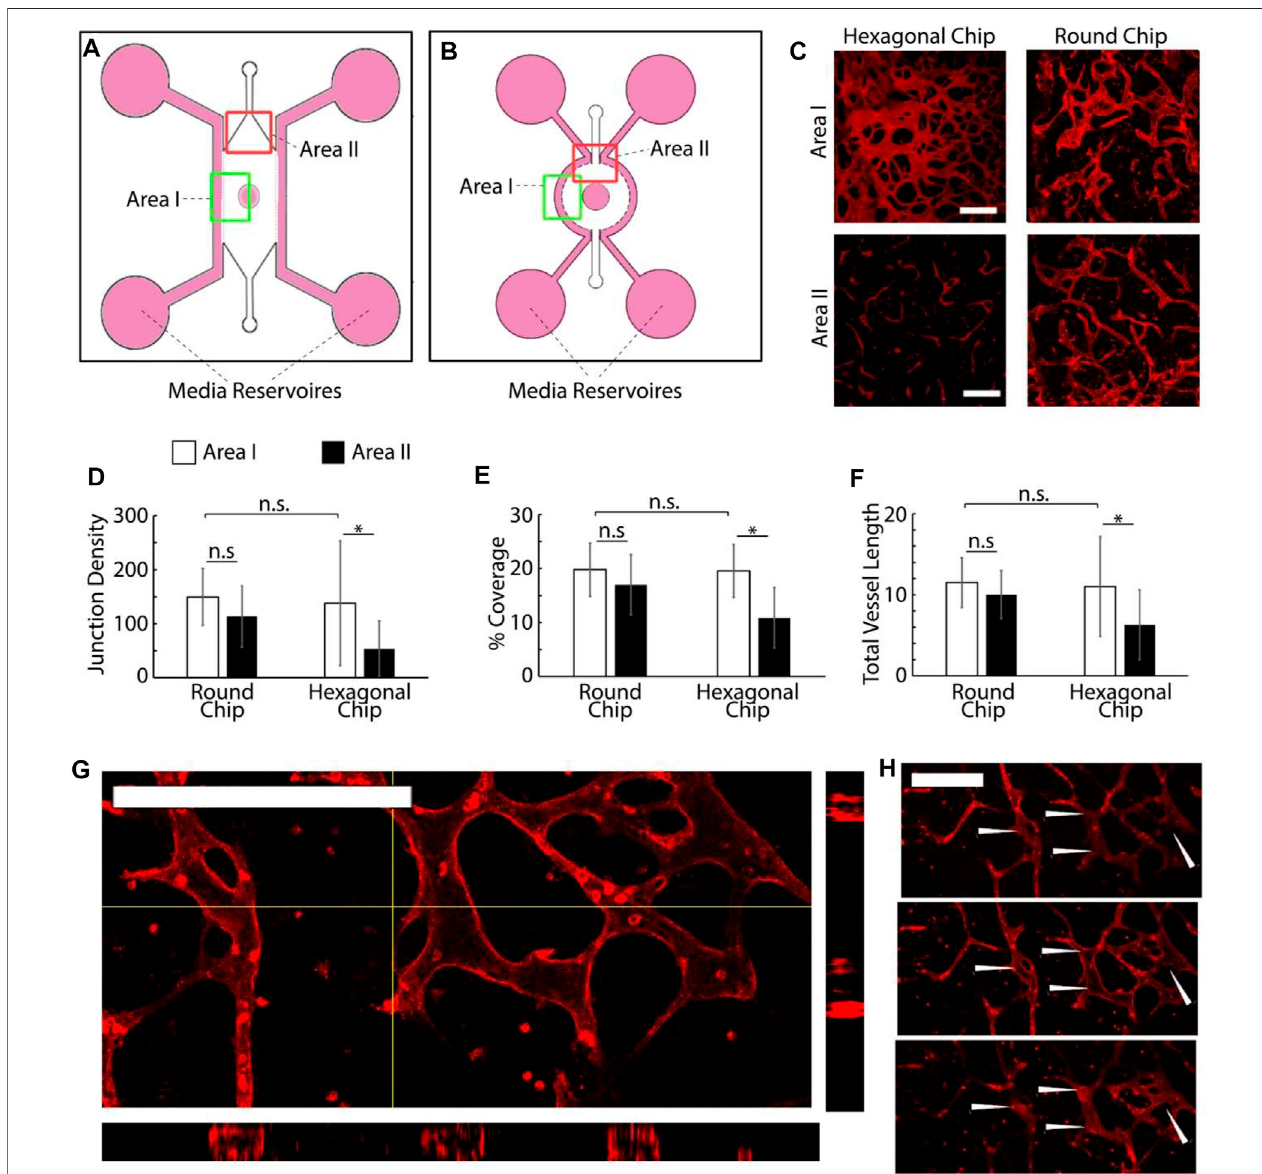
FIGURE 2 | (A,B) Schematic representation of the two chip designs investigated. (C) Examples of microvascular networks formed in different areas of the central compartment of hexagonal and round chips. Scale bars: 200 μ m. (D – F) (D − F) Quanti fi cation of the morphology of the corresponding networks. Junction density and total vessel length are expressed in arbitrary units normalised by the section area. (G – H) Confocal images of networks formed in round chips displaying luminated structures [ (G) z-stack projection and cross-section and (H) corresponding individual sections taken across one network branch]. * p < 0.05; n.s., non-signi fi cant, p > 0.05; error bars are standard errors; n = 3. Scale bars: 200 μ m.